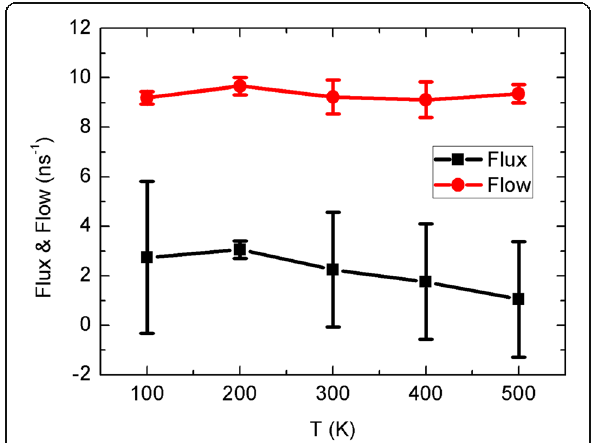
Fig. 2 The water flux and flow as a function of the sheet temperature. Error bars are shown for two data points